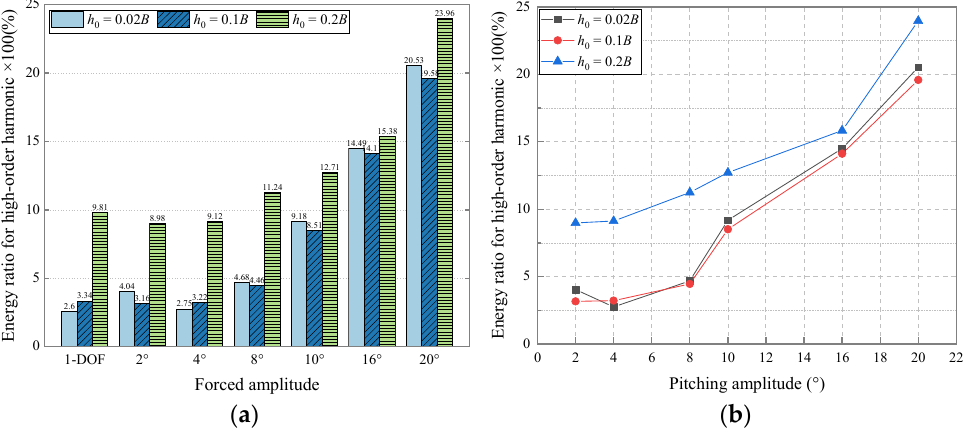
Figure 20. Proportion variation in high-order harmonic components of aerodynamic lift with different pitching amplitudes. ( a ) Comparison of 1-DOF heaving motion with 2-DOF coupled motion; ( b ) 2-DOF coupled motion.